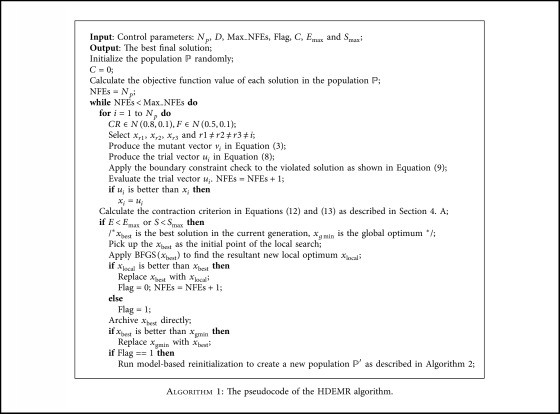
 The pseudocode of the HDEMR algorithm.